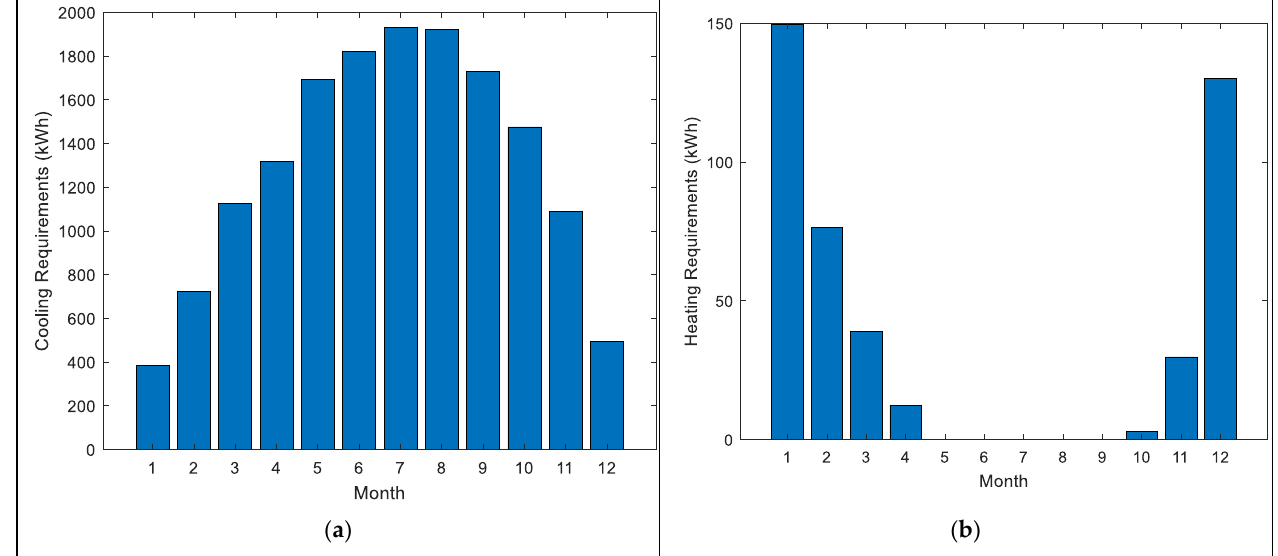
Figure 5. Monthly cooling ( a ) and heating ( b ) requirements for the building.